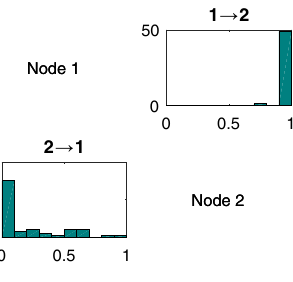
Figure 2. Histogram of lsNGC scores (normalized between 0 and 1) for the 2-logistic network over 50 different sets of the simulation. The influence of x 1 on x 2 is captured quite well across the 50 simulations. Generated with MATLAB R2016a 40